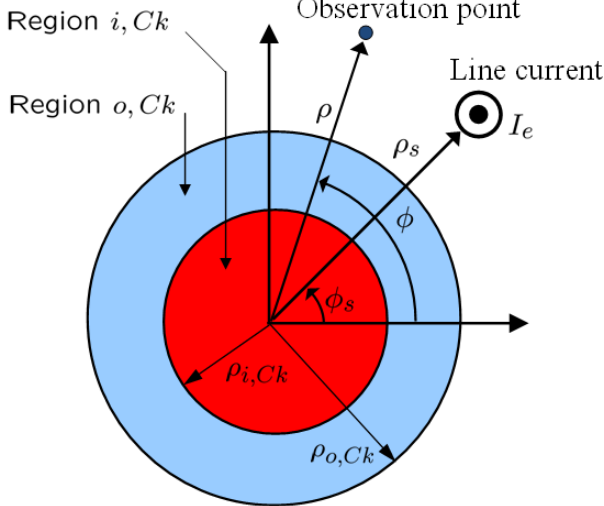
Figure 1. The k ' th concentric cylinder set of the 1-, 2-, and 4-cylinder